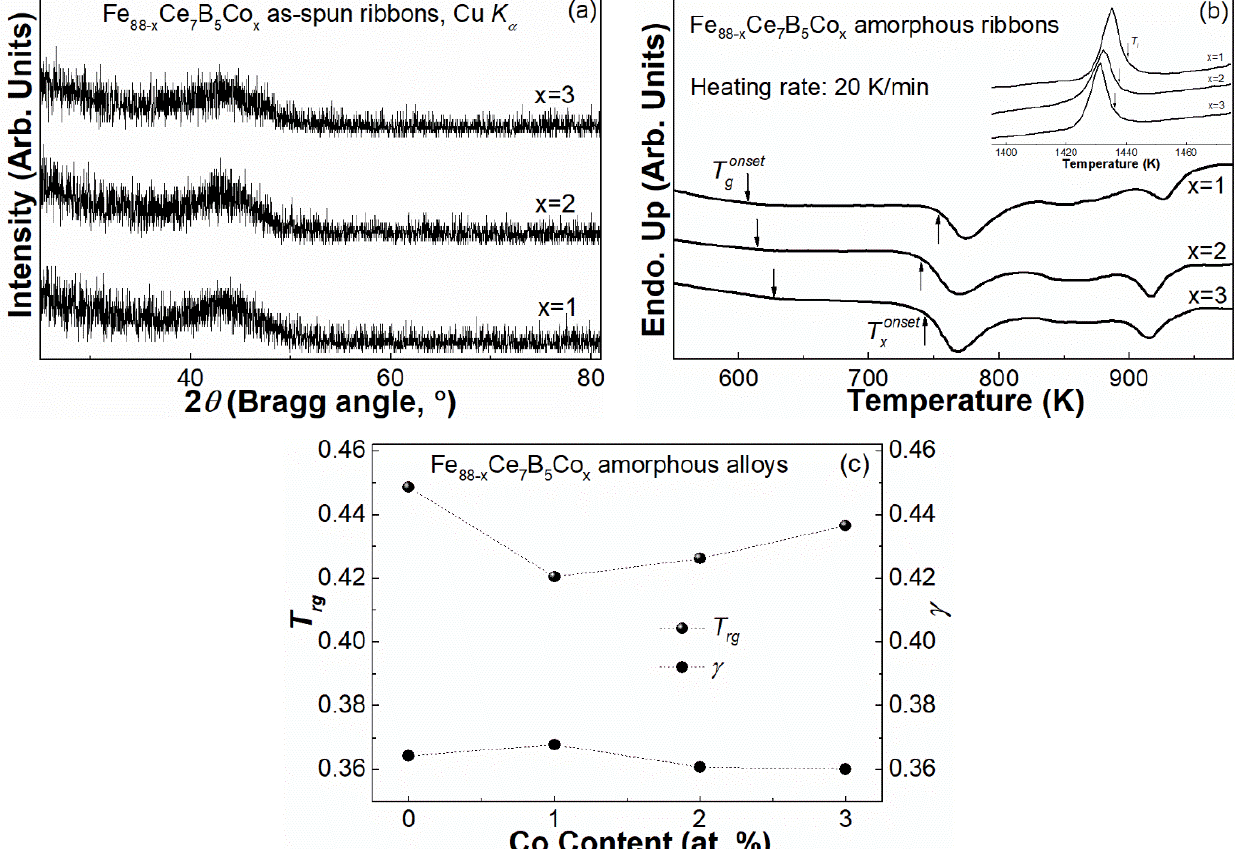
Figure 1. ( a ) XRD patterns and ( b ) DSC curves of the Fe 88- x Ce 7 B 5 Co x ( x = 1, 2, 3) as-spun ribbons; the inset is the melting behaviors. ( c ) The compositional dependence of T rg and γ for these amorphous ribbons.